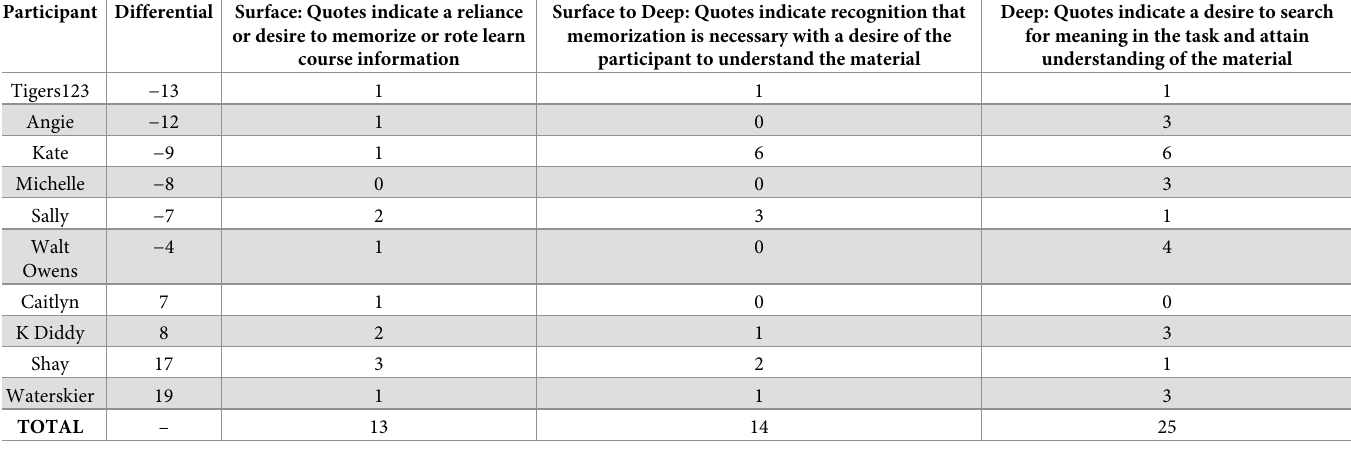
Table 4. Code definitions, participant differential scores, and number of relevant excerpts coded to